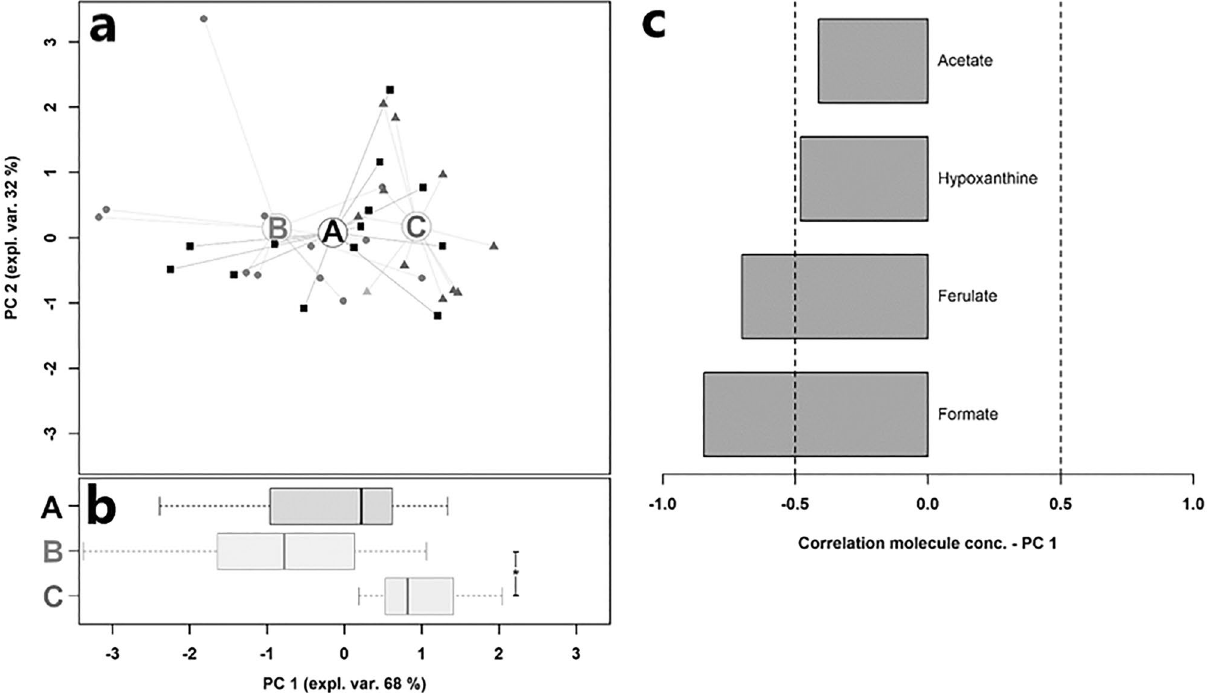
Figure 11. rPCA model on caecal metabolites of Table 4. In the score plot ( a ), samples of CON (“A”), MUL (“B”), and MUH (“C”) are drawn as squares, circles, and triangles, respectively. Wide circles are the group medians. The box plot ( b ) summarizes the position of samples along PC1. The loading plot ( c ) reports the correlations between the concentration of each metabolite and its importance over PC1. Grey bars indicate significant correlations ( p -value < 0.05).